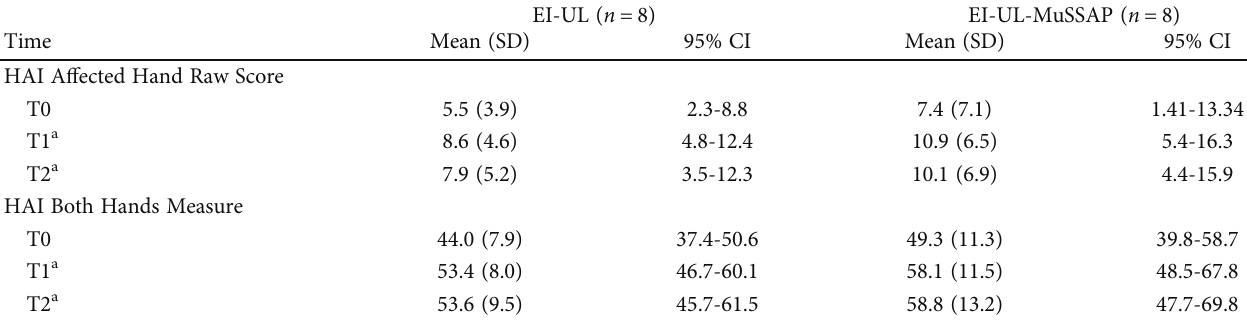
Figure 4: HAI a ff ected hand scores, BSID-III GM raw scores and GMFM-88 total scores for the intervention groups and typically developing infants on T0, T1, and T2 on the y -axis, and (corrected) age in months on the x -axis. Table 2: HAI scores before intervention (T0), after intervention (T1), and eight weeks after the intervention stopped